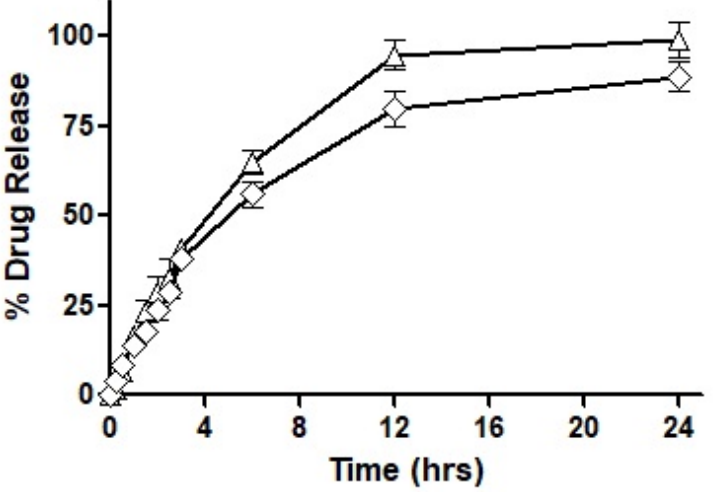
Figure 8. Comparison of the Percentage of ACV release from the nanoemulsions prepared from F7 ( △ ) and F10 ( ◇ ) using dialysis tube method.